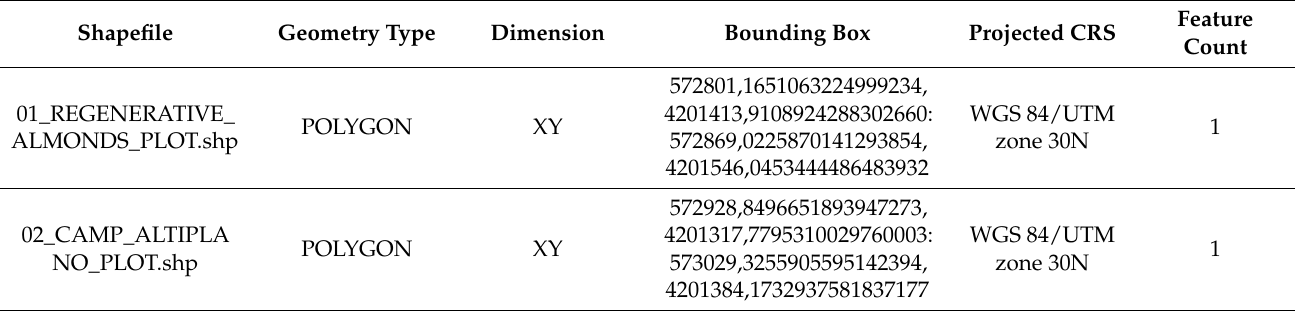
Table 14. Polygons of the Sampled